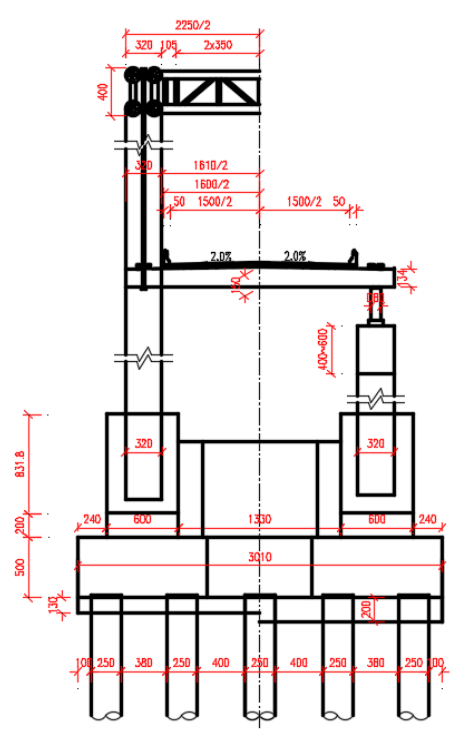
Fig. 2. Cross section